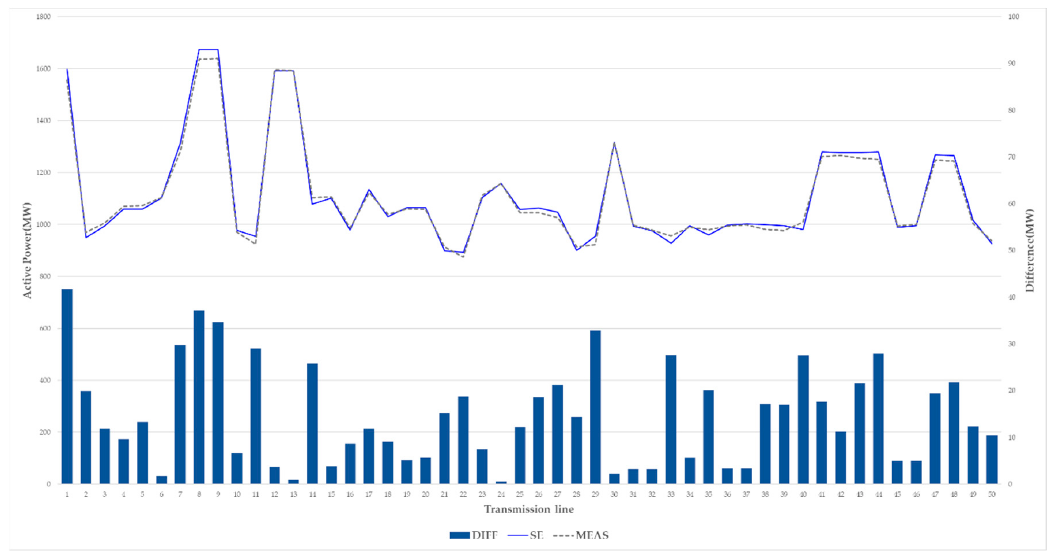
Figure 13. Branch flow for the estimation results and measurements of the 50 largest trans. lines.